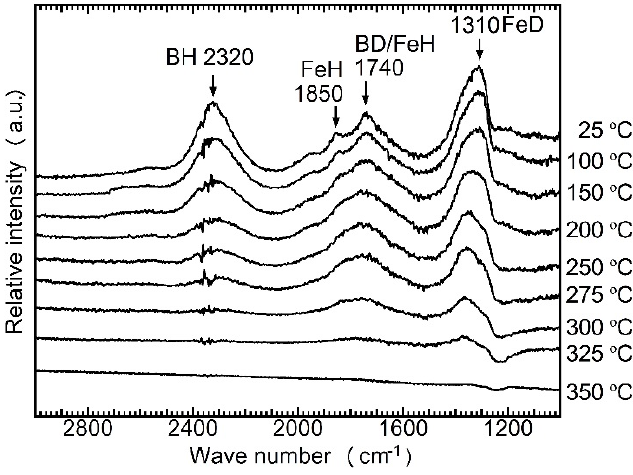
Figure 2. In situ IR spectra of ball-milled 0.25LiBH 4 + 0.75Mg 2 FeD 6 . The heating